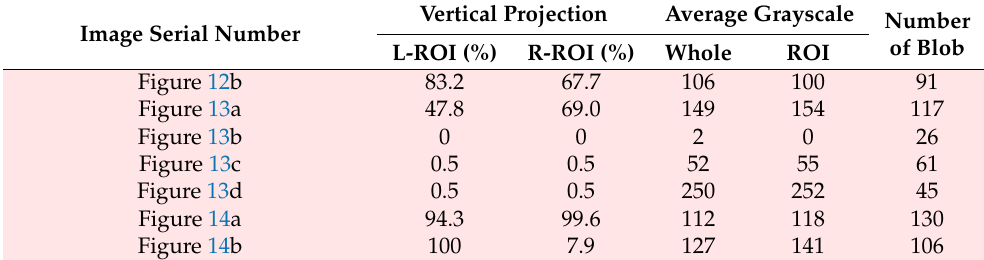
Figure 29 shows the scene of the same HSR running at different times on the same line. Due to the intermittent heavy rainfall, the blurring of the images caused by the HSC affected by rain at different moments is not the same. For the same train on the same line when it is affected differently the results of the clarity algorithm for it are shown in Table 4.